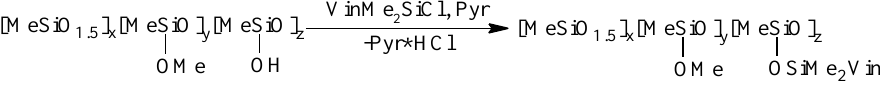
Figure 2. Scheme for the blocking reaction of the MTMS MWHP products.